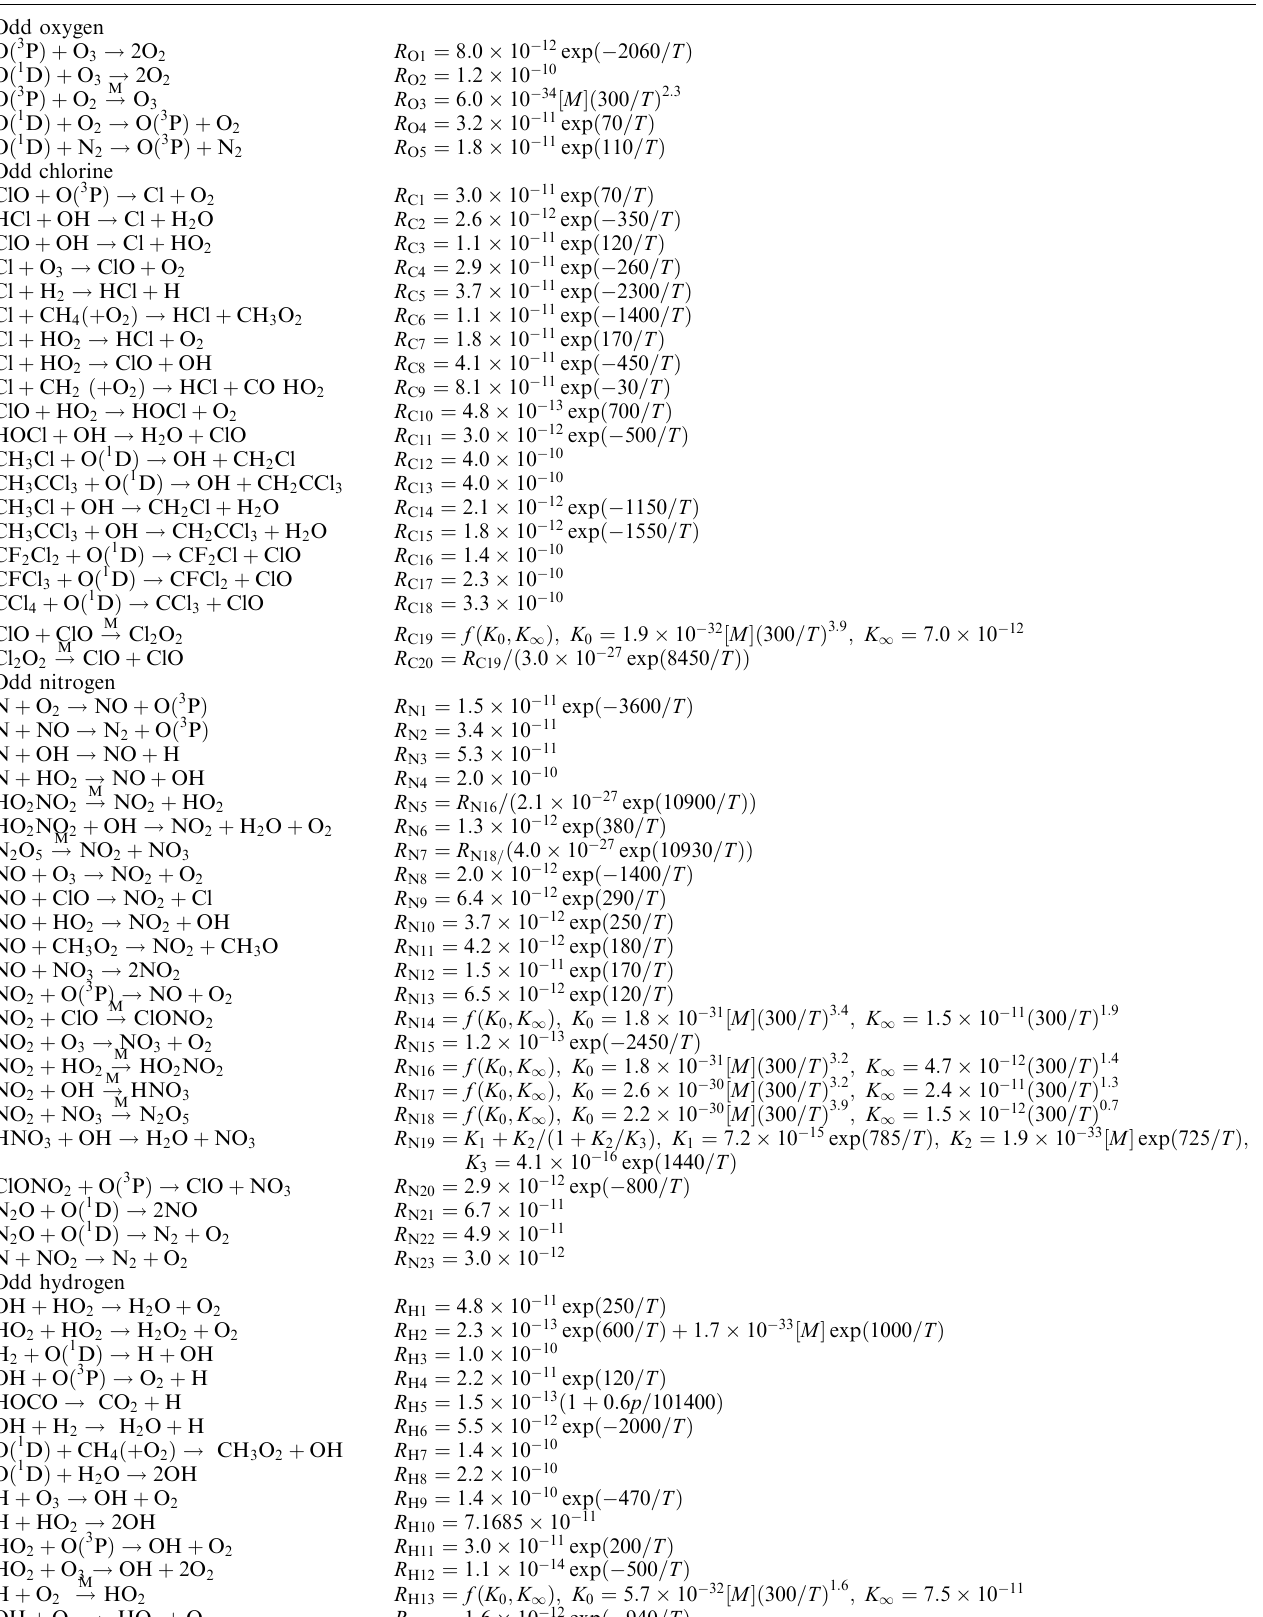
Table 2. Gasphase reactions included in the model Reaction Reaction rate [cm ) 3 s ) 1